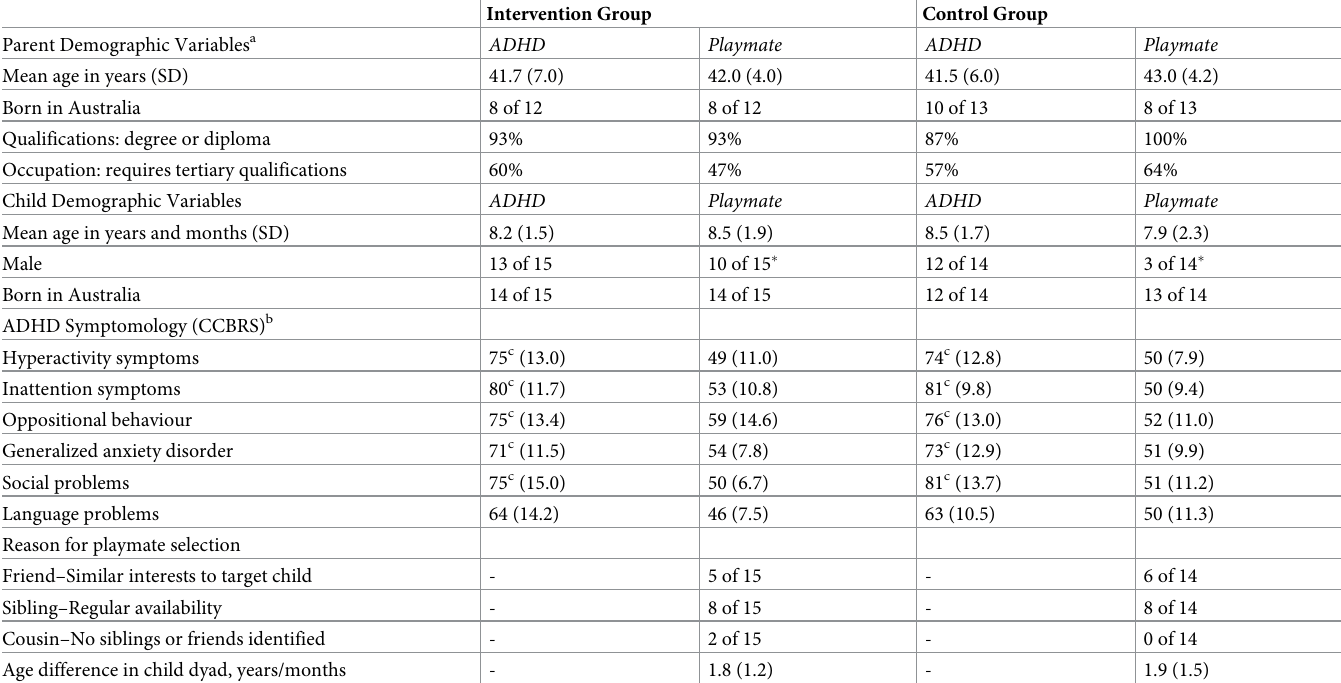
Table 1. Participant